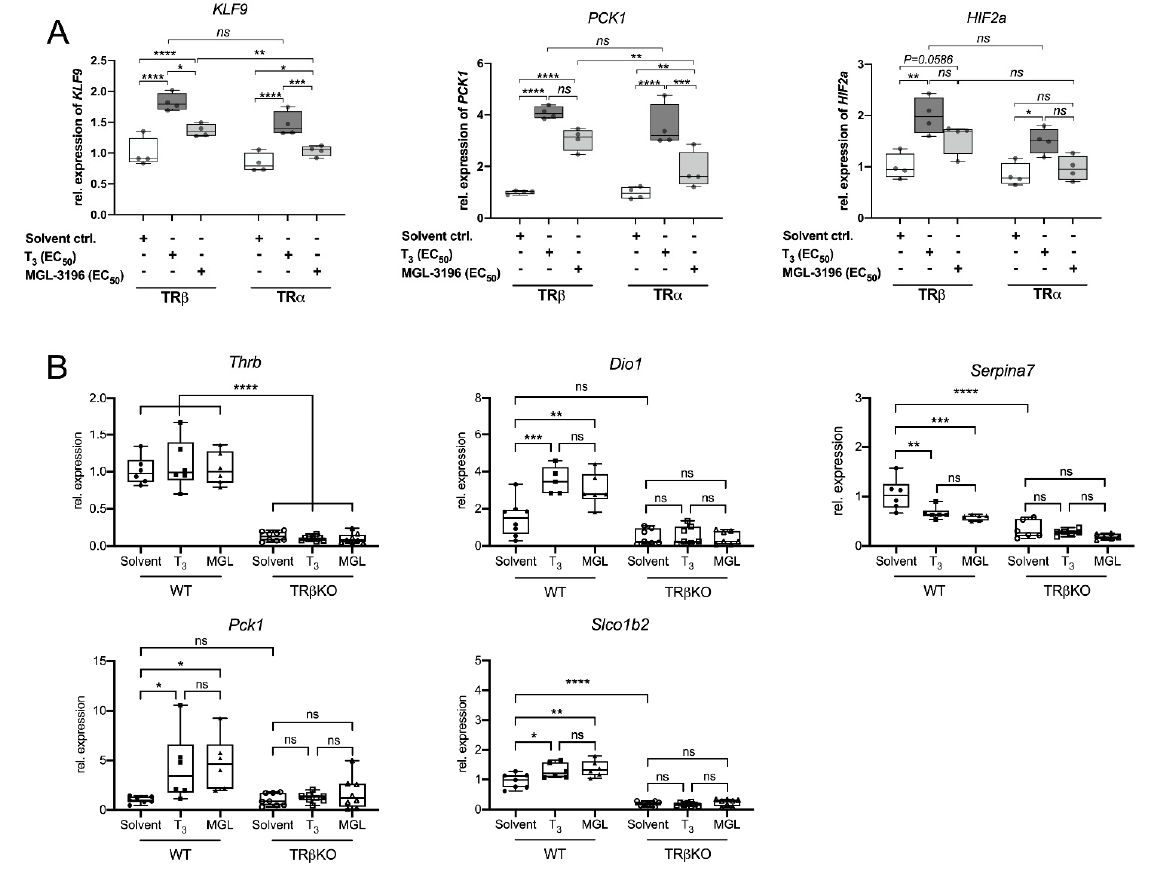
Figure 4. Gene expression analysis in HEK-1B1 cells and primary murine hepatocytes: ( A ) HEK-1B1 cells either expressing TR β or TR α were treated with 10 nM T 3 (dark grey) or 600 nM MGL-3196 (light grey) for 48 h and expression of TH target genes KLF9 (krüppel-like factor 9), PCK1 (pyruvate carboxylase kinase 1) and HIF2a (hypoxia-inducible factor 2a) was measured (n = 3); ( B ) primary murine hepatocytes of WT and TR β KO mice were treated with EC 50 of T 3 or MGL-3196 for 24 h and expression of hepatic TH target genes was analyzed by using RT-PCR. MGL-3196 and T 3 induced similar changes in gene expression of Dio1 , Serpina7 , and Pck1 (n = 6). Both T 3 and MGL-3196 led to an increased expression of Slco1b2 , the murine orthologue of the human SLCO1B1 and SLCO1B3 . One-way ANOVA with Tukey’s post hoc test: ns = not significant; * p < 0.05, ** p < 0.01, *** p < 0.001, **** p < 0.0001.